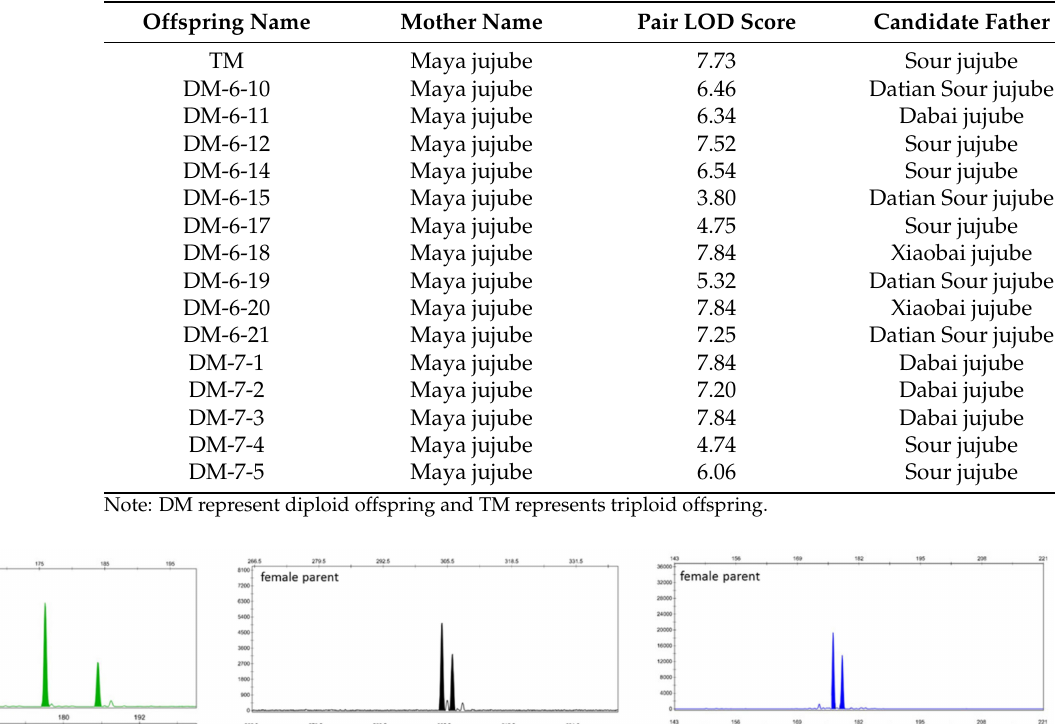
Table 5. Paternal identification results.